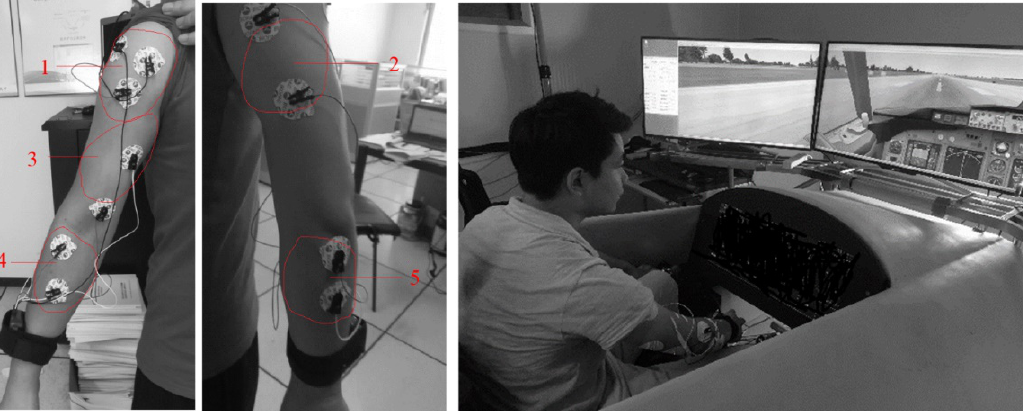
Figure 3. Schematic diagram of the locations of the upper limb muscle sEMG sensor electrode. 1. deltoid; 2. triceps; 3. biceps; 4. flexor carpi; and 5. brachioradialis.